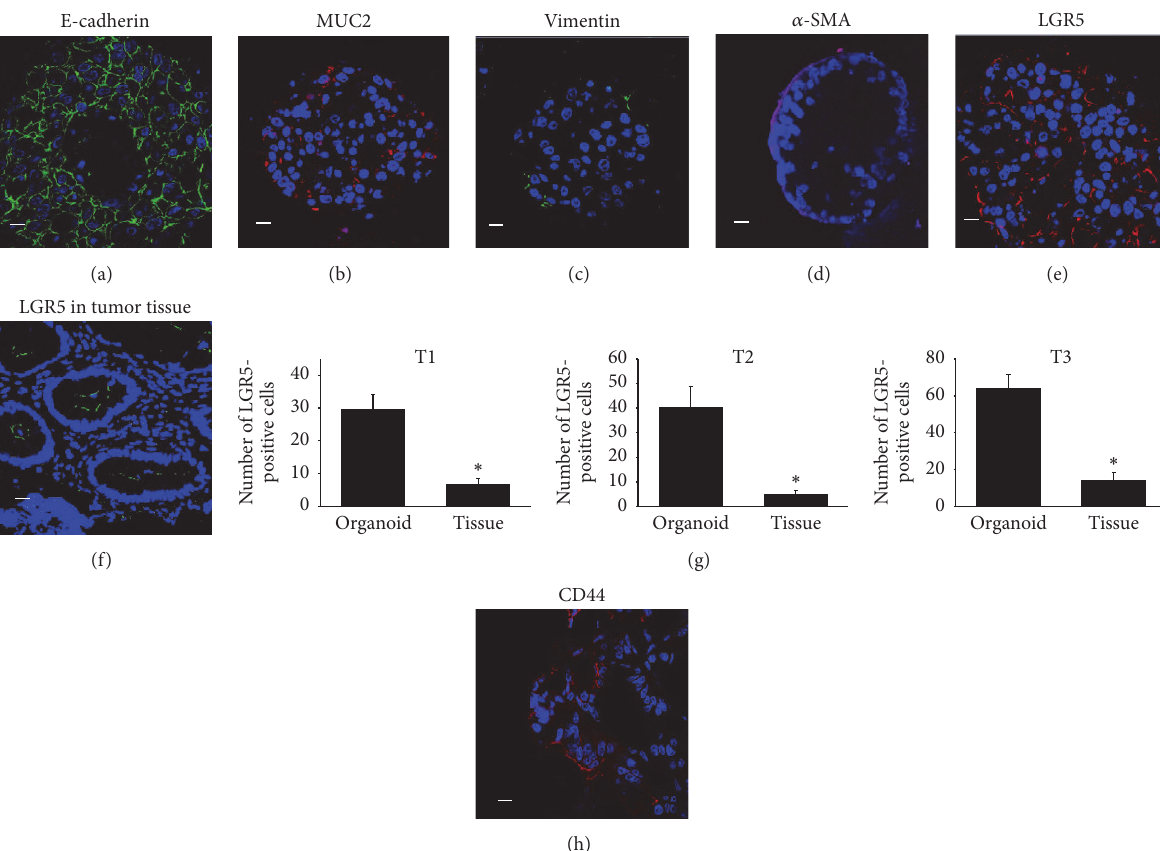
Figure 3: Expression of E-cadherin (a), MUC2 (b), vimentin (c), and 𝛼 -SMA (d) in human ALI tumor colorectal organoids. Comparison of a cancer stem cell marker, LGR5 expression in tumor organoids (e), and primary tumor tissues (f). The number of LGR5-positive cells in the pictures was counted ((g) n = 4, each for three patients (T1, T2, and T3)). ∗ 𝑃 < 0.05 versus organoid. Expression of CD44 (h) in human ALI tumor colorectal organoids. The paraffin sections (4 𝜇 m) were immunofluorescently stained using antibody against E-cadherin, MUC2, vimentin, 𝛼 -SMA, LGR5, and CD44. Representative photomicrographs are shown ( n = 4). Culture days 14–21. Scale bar: 50 𝜇 m.